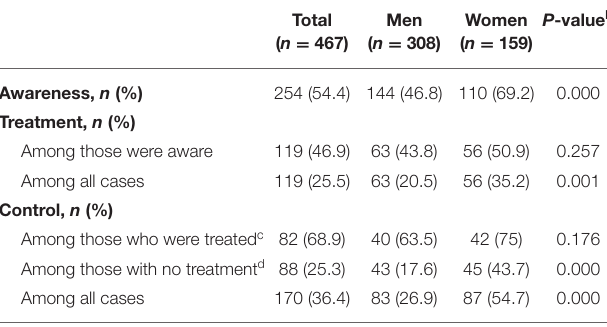
TABLE 2 | Awareness, treatment, and control of hypertension among individuals with hypertension by sex at baseline ( n = 467) a